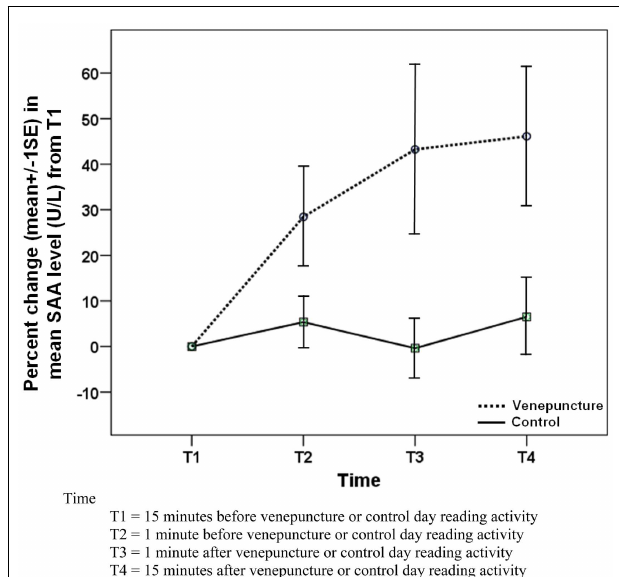
FIGURE 3 | Comparison of change in SAA level between venepuncture and control days among 33 subjects .